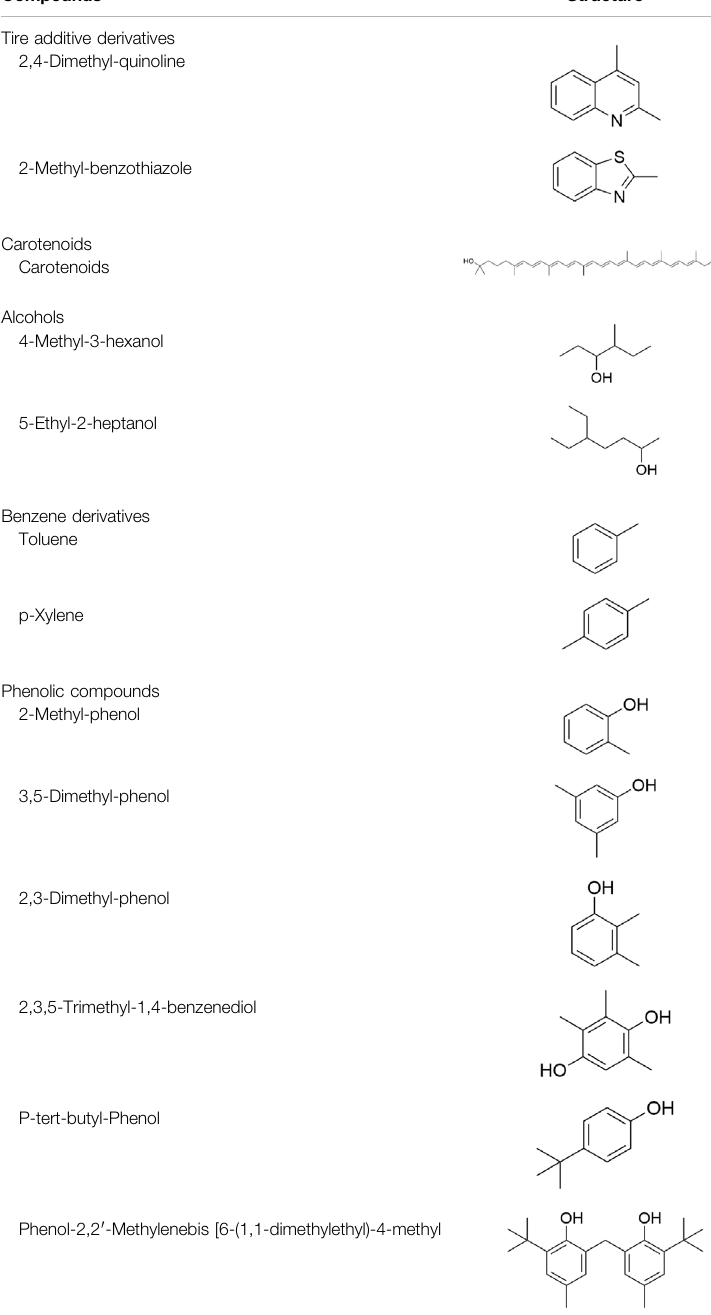
TABLE 3 | Major organic compounds in the liquid phase at different reaction conditions. Compounds